Question: Write a single sentence explaining what this figure depicts.
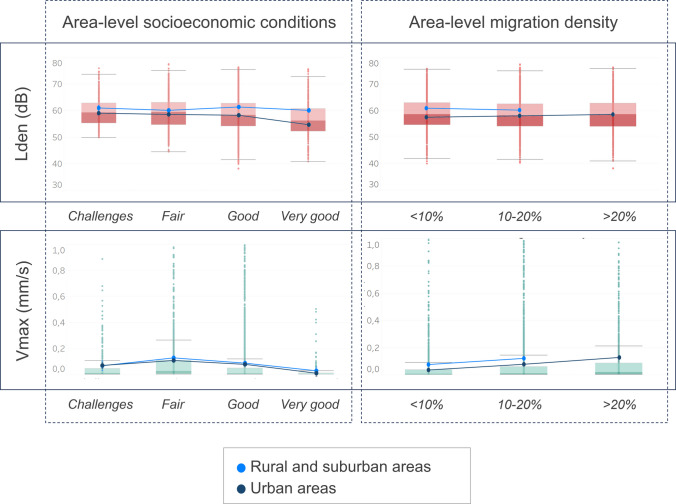
Answer: Boxplots for the distribution of noise and vibration according to (i) area-level socioeconomic conditions and (ii) area-level migration density. Connected lines represent the predicted exposure values following the interaction analysis on the impact of area-level indicators on noise and vibration according to urbanicity classes (rural-suburban versus urban areas)